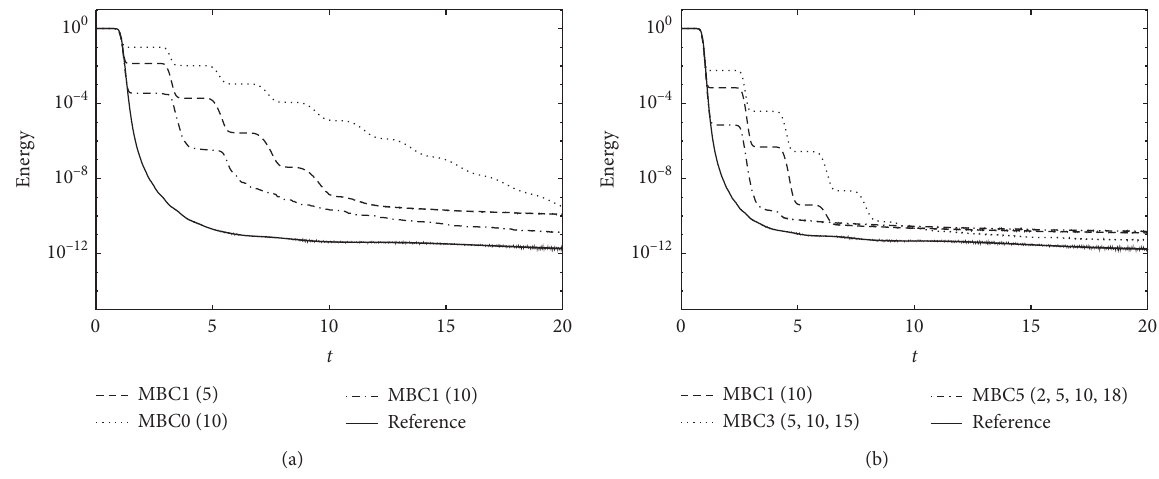
Figure 9: Energy of wave packet with the major wave number: (a) k � 10; (b) k �